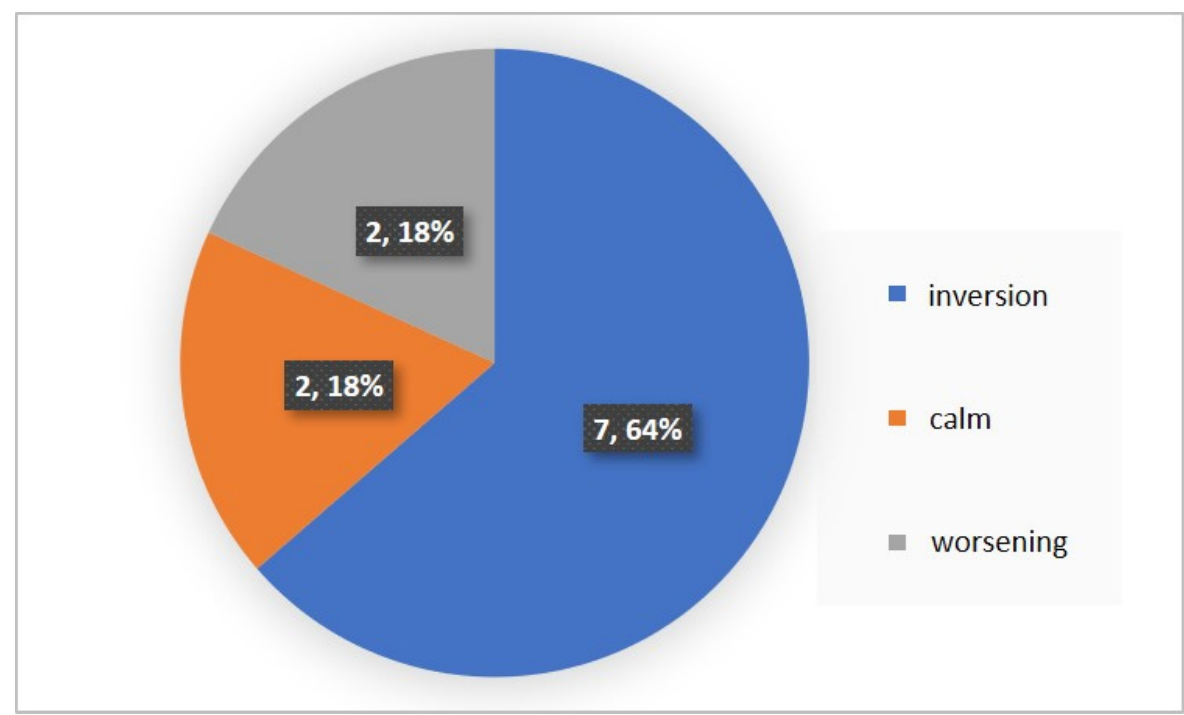
Figure 20. Percentage of responses to stimuli in volunteers when using the Basic complex.